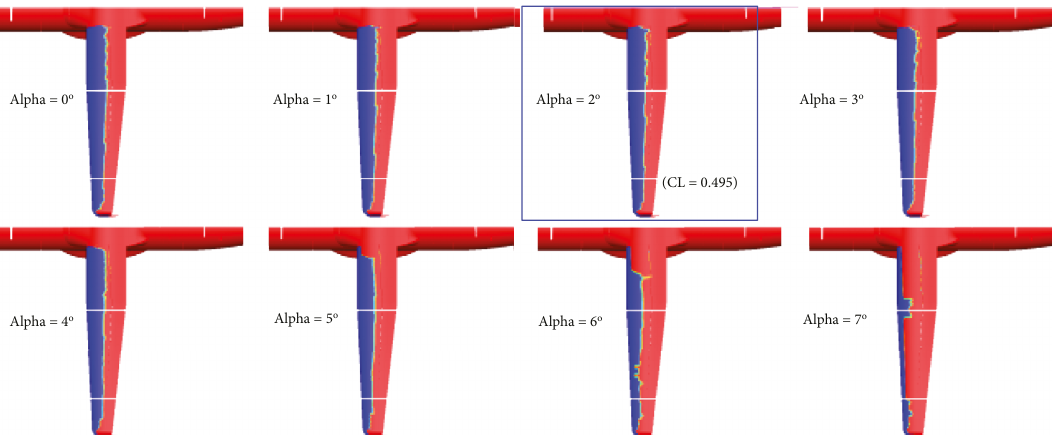
Figure 10: AG2-NLF plane: computed transition location on the wing upper surface at cruise conditions ( M = 0 52 @ 20000ft). Blue=laminar, red